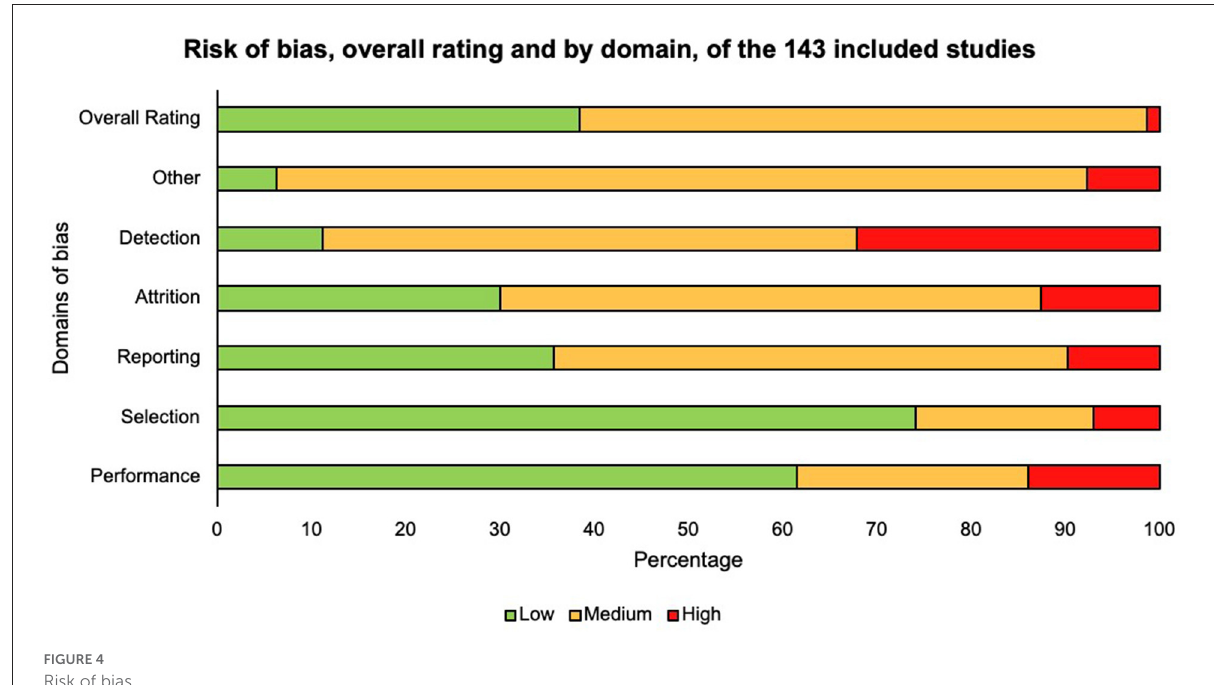
FIGURE4 Risk of